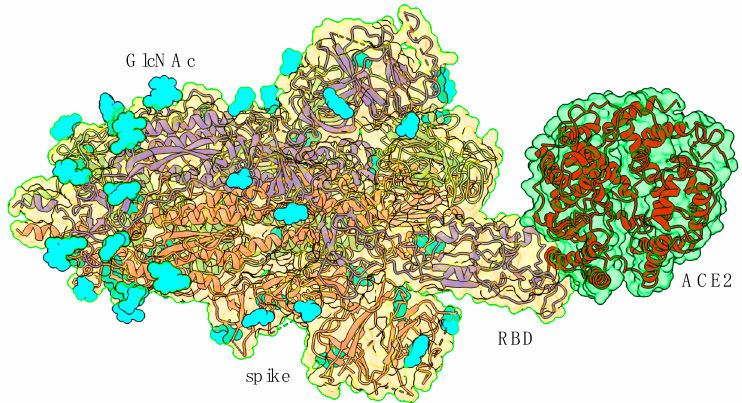
Figure 1. Molecular structure of the SARS-CoV-2 variant B.1.1.17 ( α ) spike in complex with ACE2 (PDB code 7FEM), showing how the RBD in an open conformation interacts with ACE2. The three S-proteins forming the homotrimeric spike are colored violet, red and green. The putative N -glycosylation sites occupied by GlcNAc are represented by cyan-colored balls.